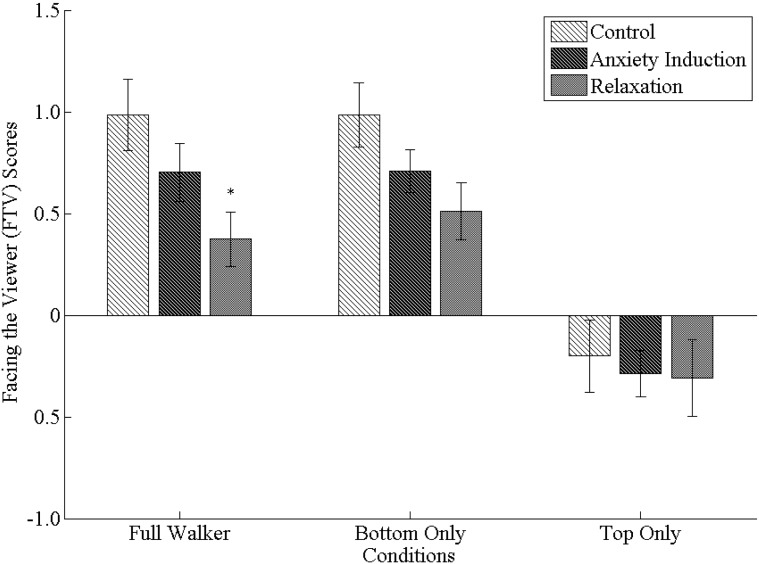
Mean facing-the-viewer (FTV) scores for full stick figure walkers, bottom-half-only stick figure walkers, and top-half-only stick figure walkers (grouped on x-axis) in Experiment 2.Mean FTV scores are displayed separately for the control, anxiety induction, and relaxation conditions (grouped as differently shaded bars). Note that *indicates a significant simple main effect, whereby FTV scores in the relaxation condition were significantly lower than either the walking or jogging conditions for full stick figure walkers only. No other simple main effects were significant. Error bars represent standard error of the mean.